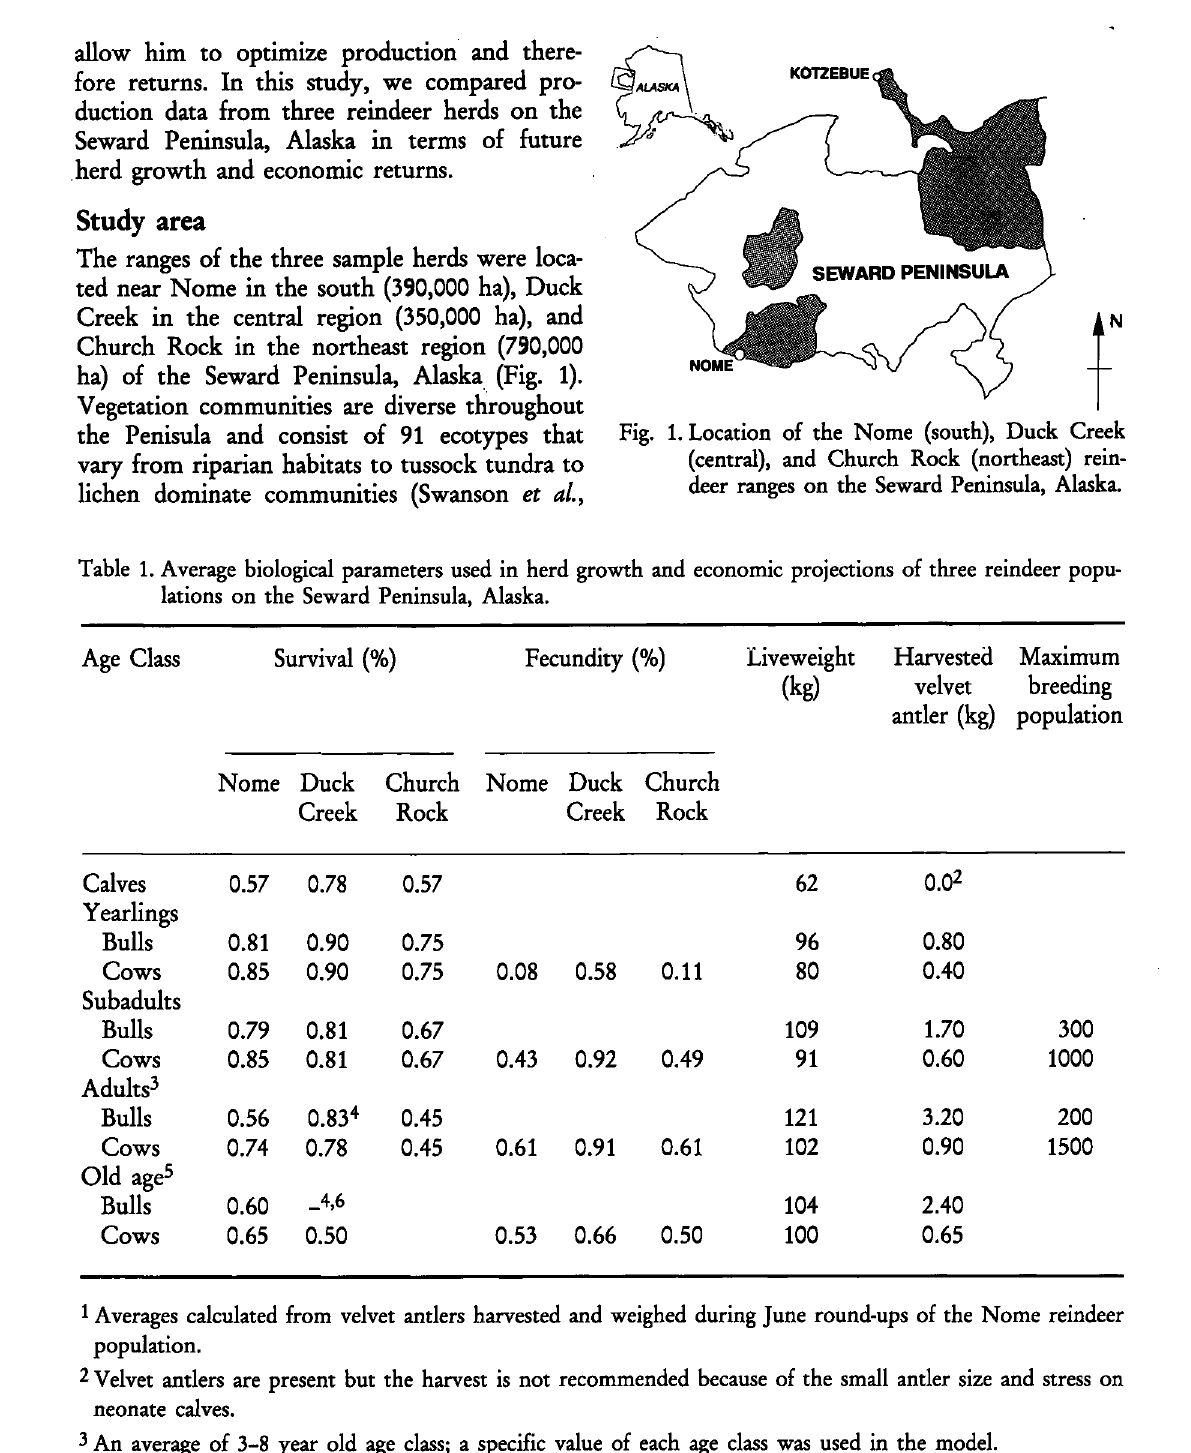
Fig. 1. Location of the Nome (south), Duck Creek (central), and Church Rock (northeast) rein deer ranges on the Seward Peninsula, Alaska.